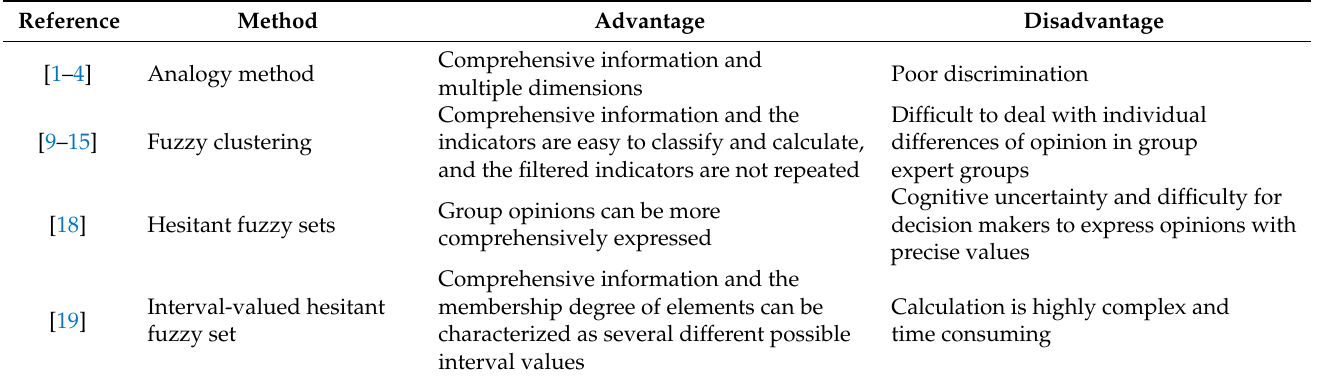
Table 1. Methods for enterprise